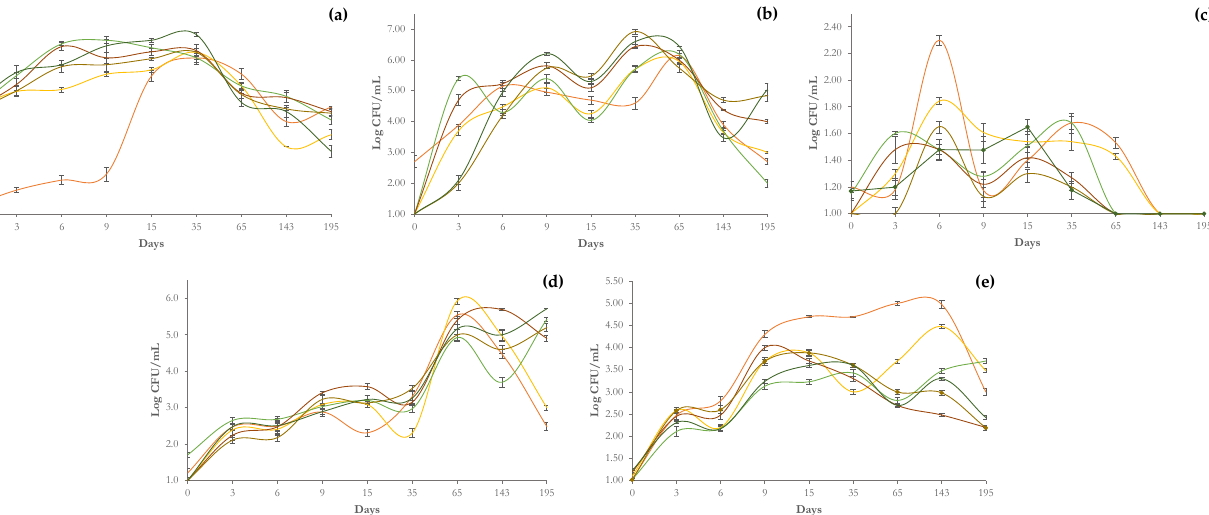
Figure 2. Trend of microbial populations determined during 195 days of fermentation: ( a ) lactic acid bacteria; ( b ) yeasts; ( c ) Enterobacteriaceae; ( d ) Pseudomonadaceae; ( e ) Staphylococcaceae. Colours: ▬ , NdB-1 (spontaneous fermentation); ▬ , NdB-2 (L . pentosus OM13) ; ▬ , NdB-3 ( L. pentosus OM13 + nutrient A); ▬ , NdB-4 (L . pentosus OM13 + nutrient B); ▬ , NdB-5 (L . pentosus OM13 + nutrient C); ▬ , NdB-6 (L . pentosus 255 OM13 + nutrient D).